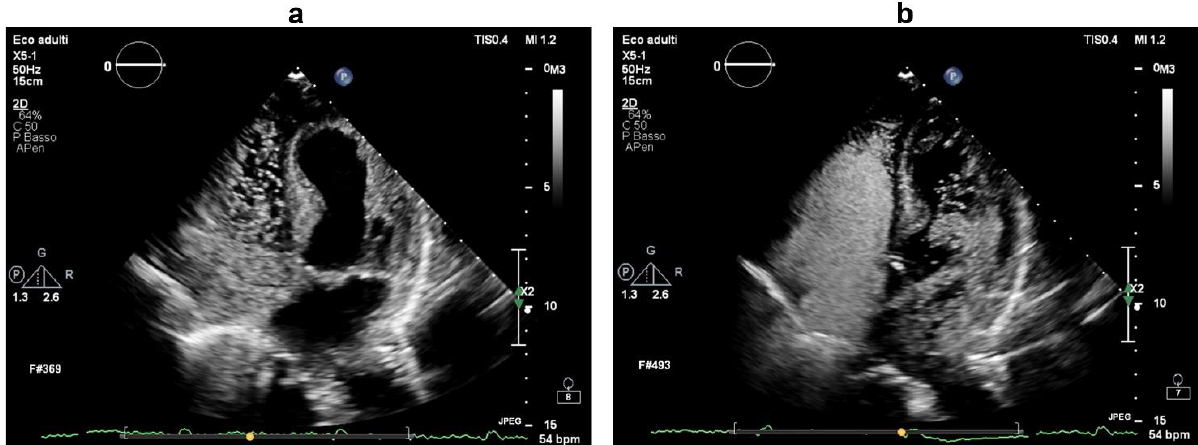
Figure 3. Transthoracic echocardiogram (apical four-chamber view) during intravenous infusion of agitated saline associated with a Valsalva manoeuvre. In ( a ), saline contrast can be seen filling the right heart chambers. In ( b ), numerous microbubbles (>20) can be visualized in the left heart chambers within three cardiac cycles from complete opacification of the right atrium, demonstrating a high-grade right-to-left intracardiac shunt consistent with patent foramen